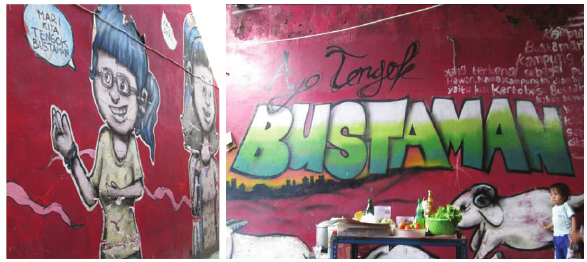
Figure 4. Th e mural as the refl ection of the community’s